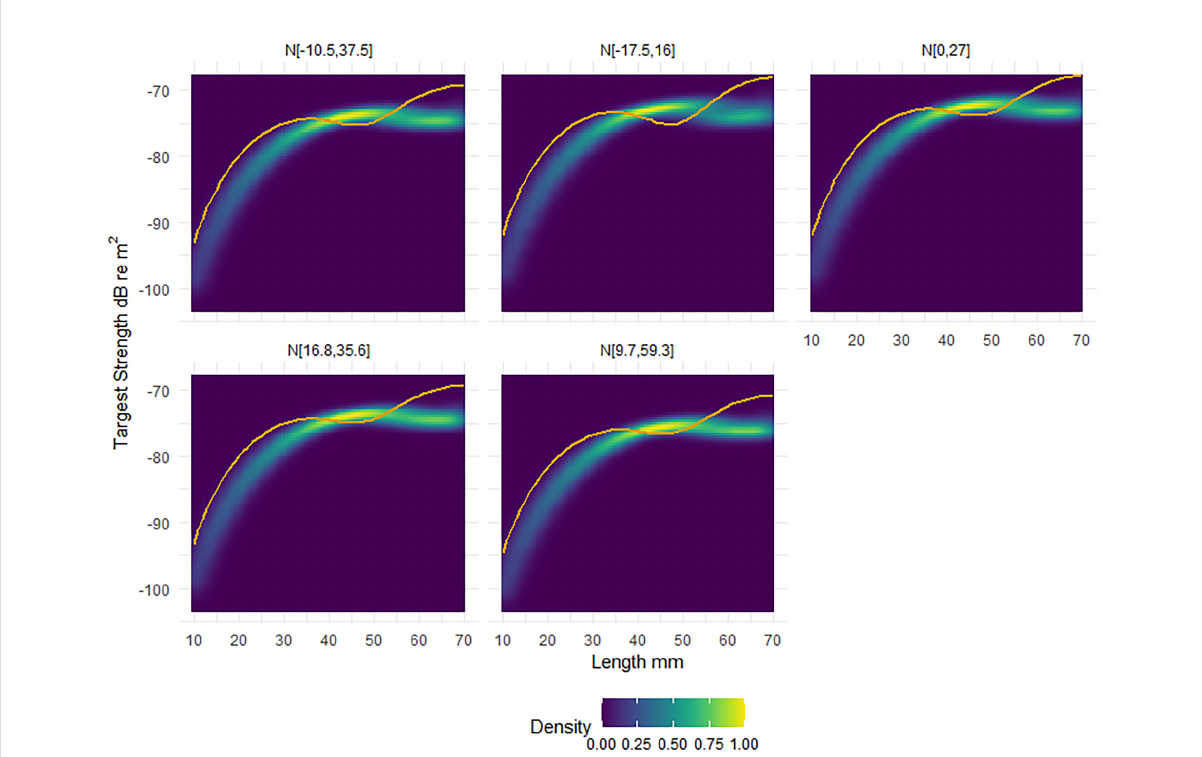
FIGURE 4 Heatmaps of the standardised relative density, scaled to one, of target strength (TS) responses of the shape catalogue as a function of length. Five orientation distributions, from in situ measurements, were considered: N [-10.5°,37.5 rc ], N [-17.5°,16°], N [0°,27°], N [16.8°,35.6°], N [9.7°,59.3°]. Overlaid on each panel is the corresponding TS response of the generic shape (orange line). The x axis of length ranges from 10 to 70 mm, with TS calculated each 1 mm